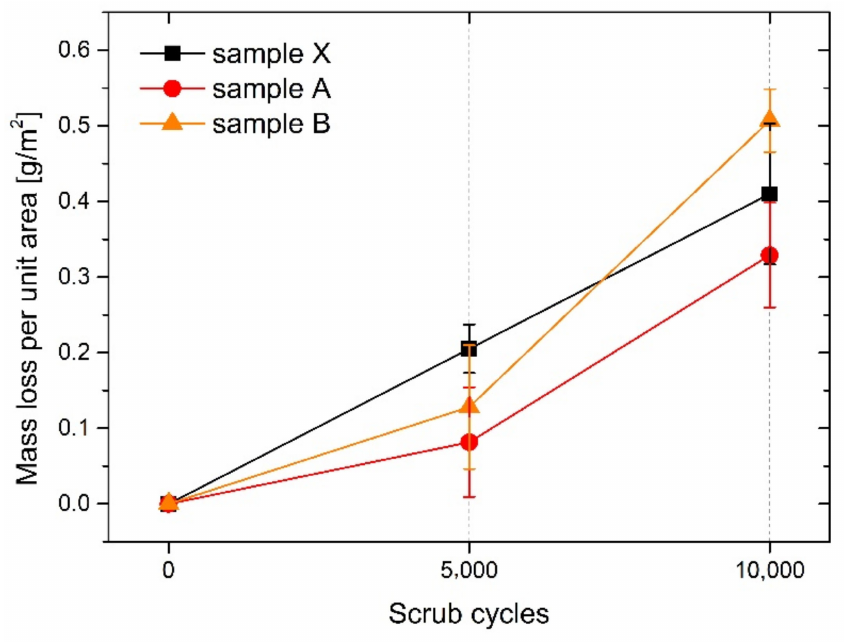
Figure 8. Loss in coatings mass per unit area, as a function of the abrasion cycles